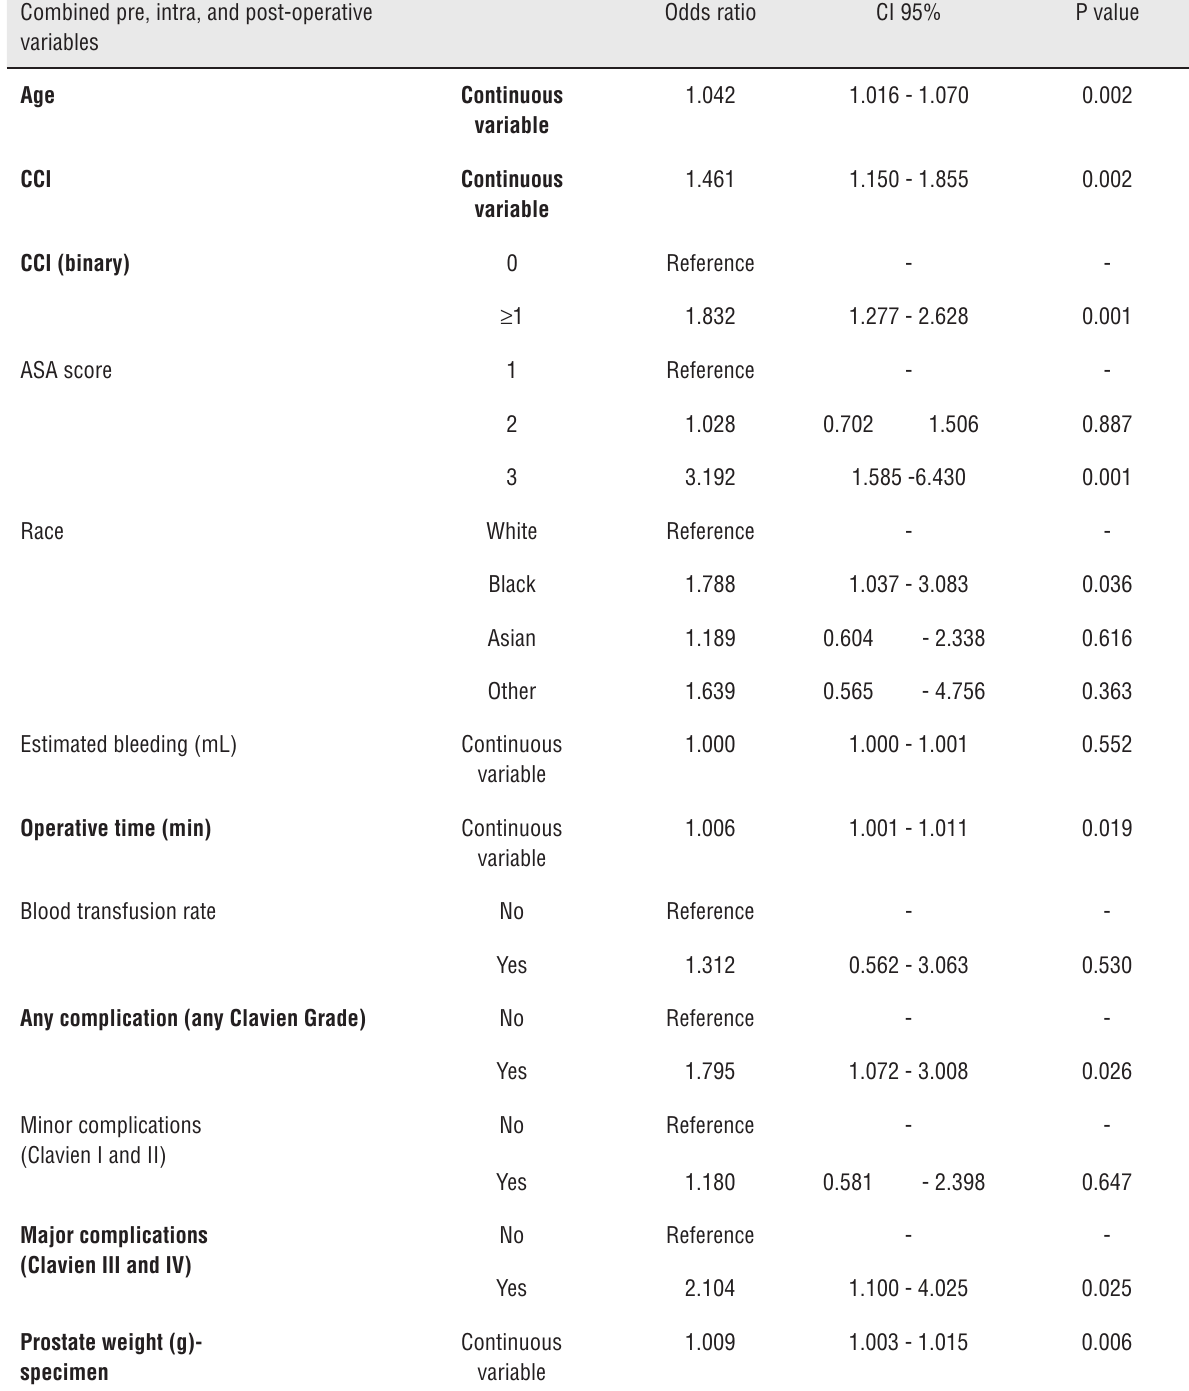
Table - 7 B) Multivariate analysis – Predictors of prolonged hospitalization including combined pre, intra, and post- operative